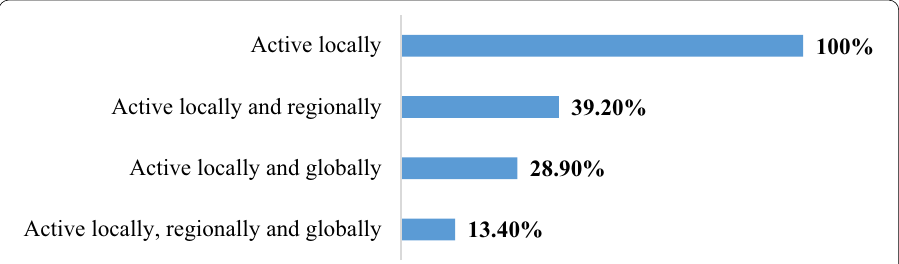
Fig. 2 Local, regional and global operation activity of the SESOs in Jordan